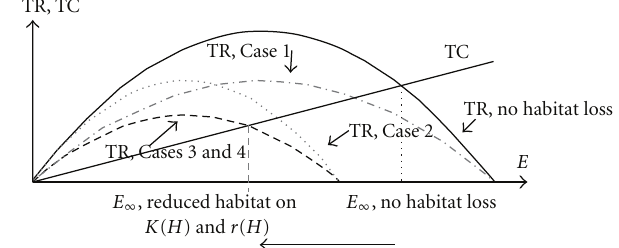
Figure 6: Habitat e ff ects on open access e ff ort for each of the biophysical models. Reduced or damaged habitat results in lower e ff ort. Table 2: E ff ects of habitat loss on biophysical models, price, and catchability.